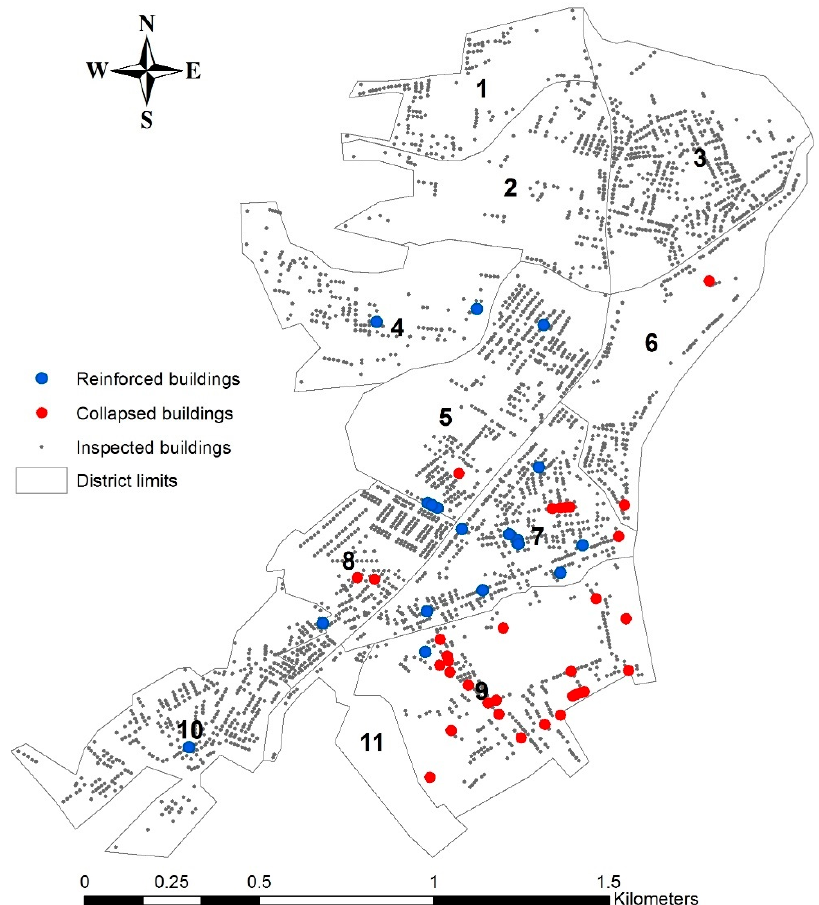
Figure 5. District limits and studied buildings in the city of Imzouren.